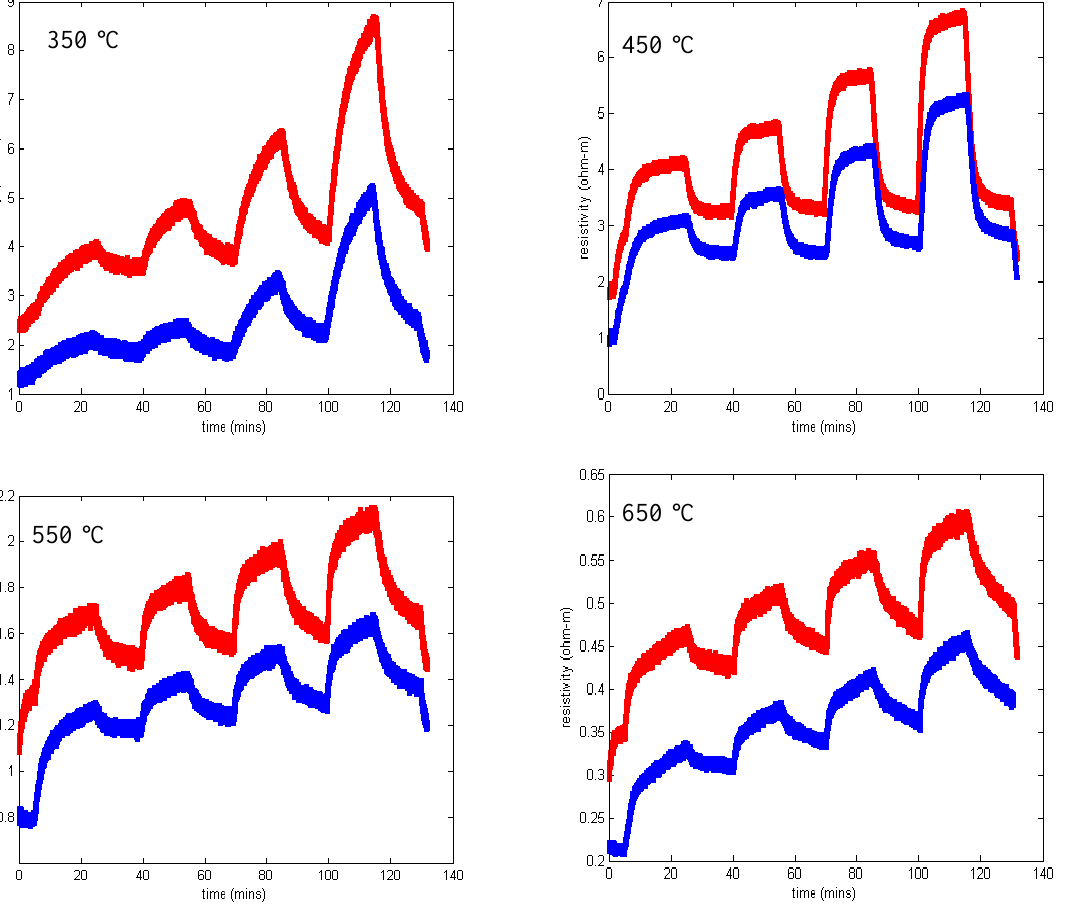
on langasite substrate from 350 °C 2